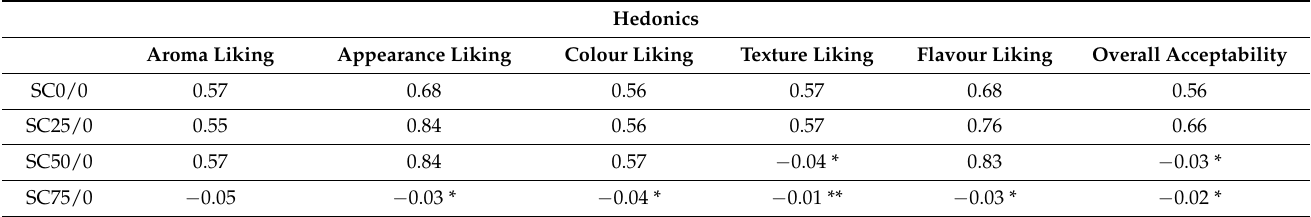
Table 4. Significance of estimated regression coefficients (ANOVA values) for the relationship of hedonic sensory parameters (Y) and sponge cake samples prepared with increasing levels of sucrose replacement